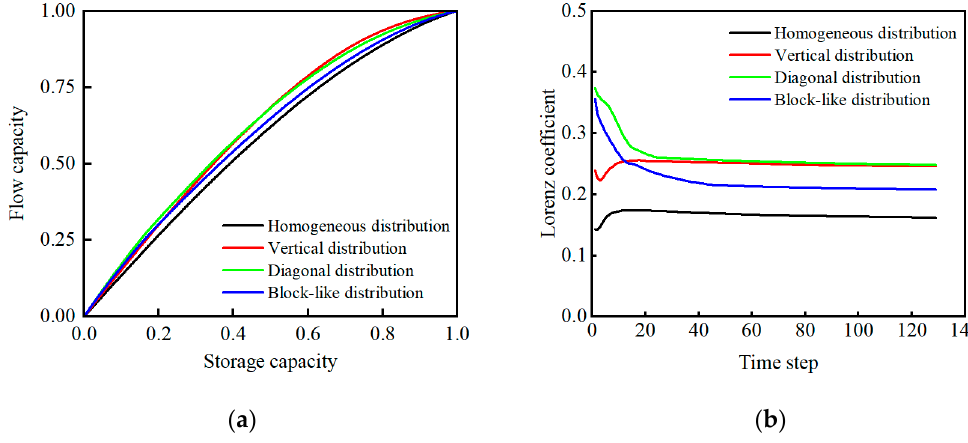
Figure 13. Comparison of flow heterogeneity under different permeability distributions. ( a ) Lorenz curve; ( b ) flow heterogeneity curve.